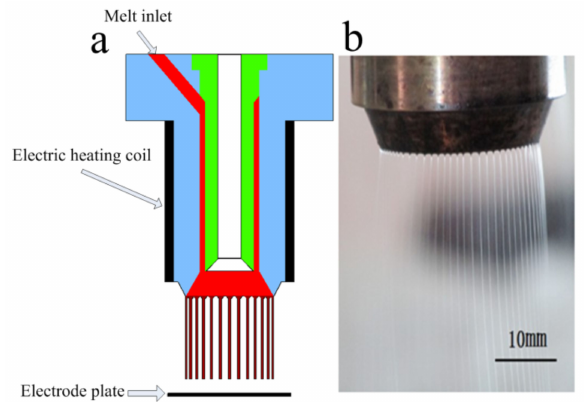
Figure 1. Needleless melt electrospinning of annular tip nozzle: ( a ) schematic, ( b ) photo.